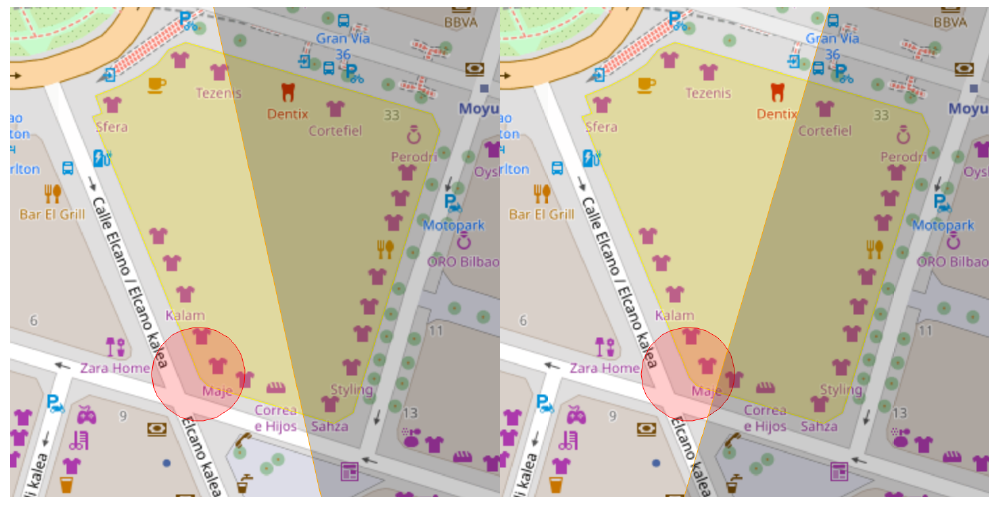
Figure 23. Initial surface subtracted by limits B and C.